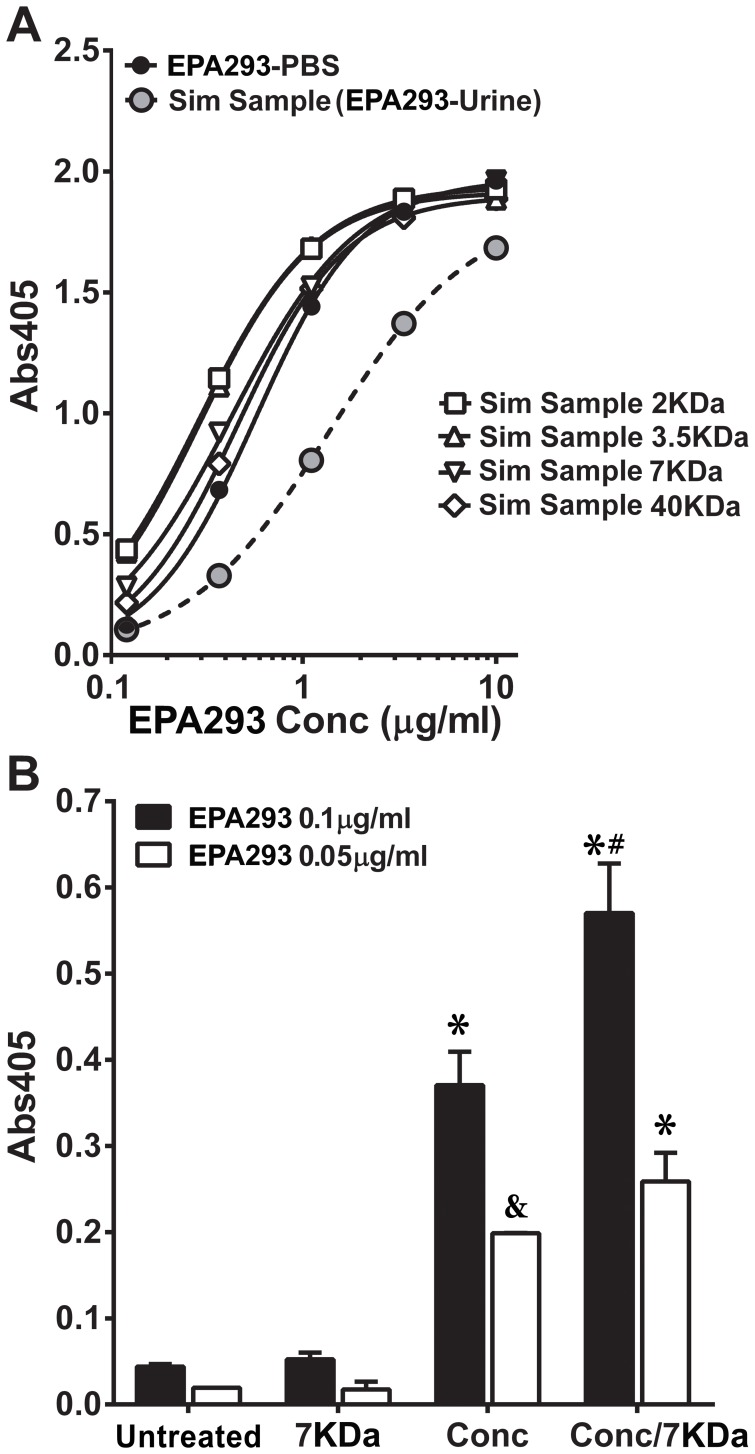
Desalting/dialysis and/or concentration improve antigen detection in simulated urine samples in sELISA.
A, Detection of EPA293 in simulated (spiked) samples after desalting or dialysis at different MWCOs (40 KDa, 7 KDa, 3.5 KDa and 2 KDa); signal curves in PBS or in all treated urine were significantly (comparison of EC50; p<0.0001, F-test) different than in untreated urine. B, Detection of low, but biologically plausible (50 and 100 ng/ml), EPA293 concentrations in simulated samples after desalting (7 KDa), concentration (5–10 folds; 3 KDa spin-column), or both, compared to no treatment. (*) represents comparisons between a treatment and untreated urine with significant difference (p<0.01); (&) represents a trend (p = 0.0613) in comparison between a treatment and untreated urine; (#) represents comparison between concentration/desalting and concentration-only treatments with significant difference (p = 0.0077); all comparisons by One-way ANOVA with a Tukey's post-test for pair-wise comparisons; N = 2–3.